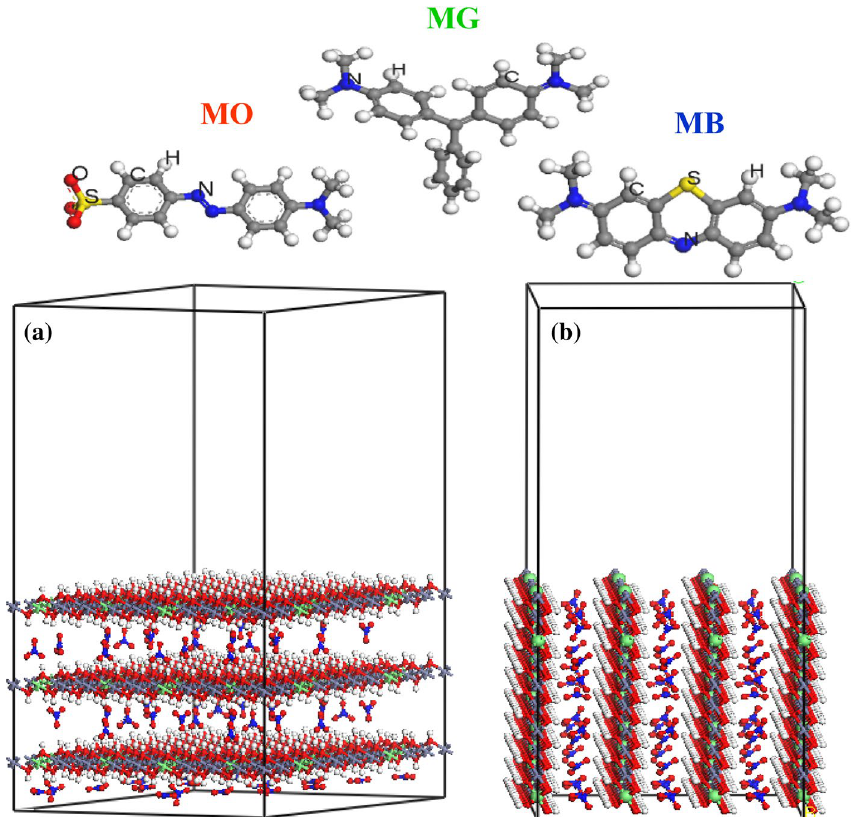
Figure 2. The optimized dye molecules and ( a ) Zn–Fe LDH (0 0 1) and ( b ) Zn–Fe LDH (0 1 0) surfaces; Fe atoms (cyan), Zn atoms (violet), O atoms (red), N atoms (blue), H atoms